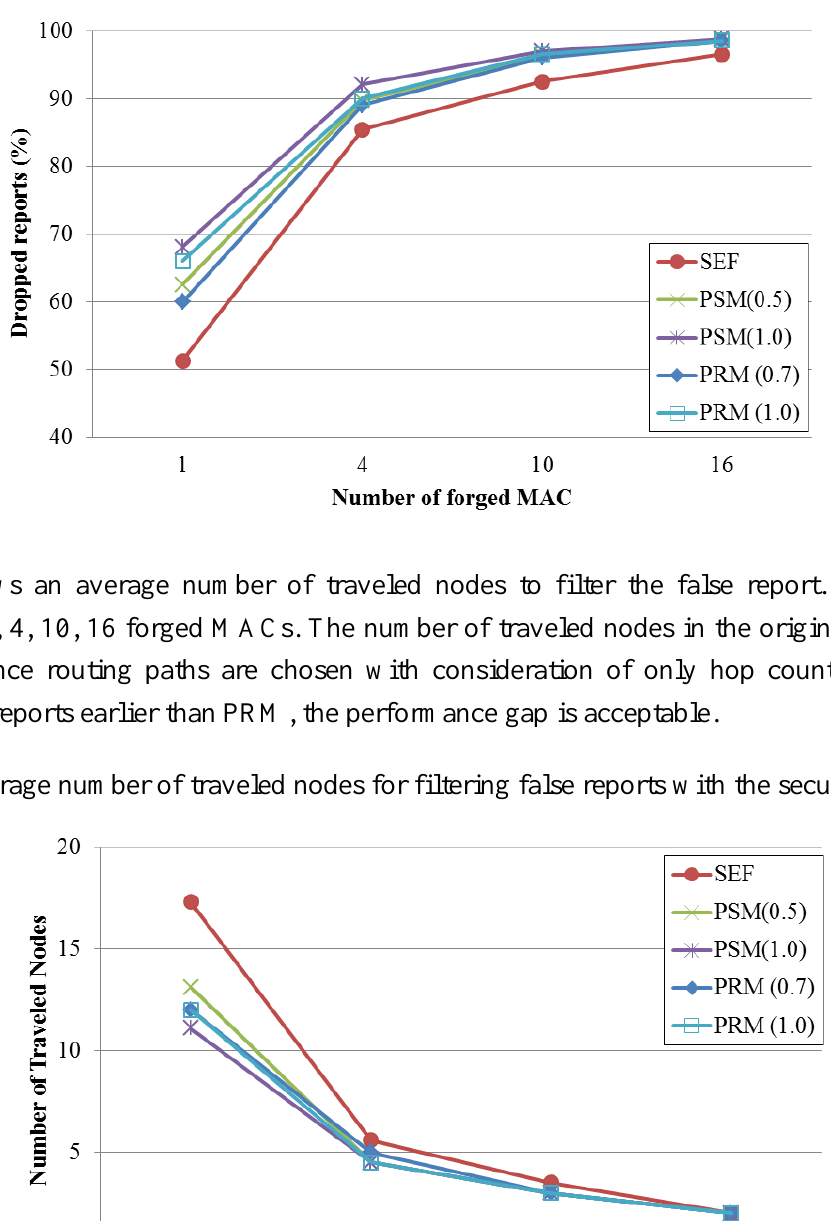
Figure 3. Ratio of filtered false reports with the security value (α).